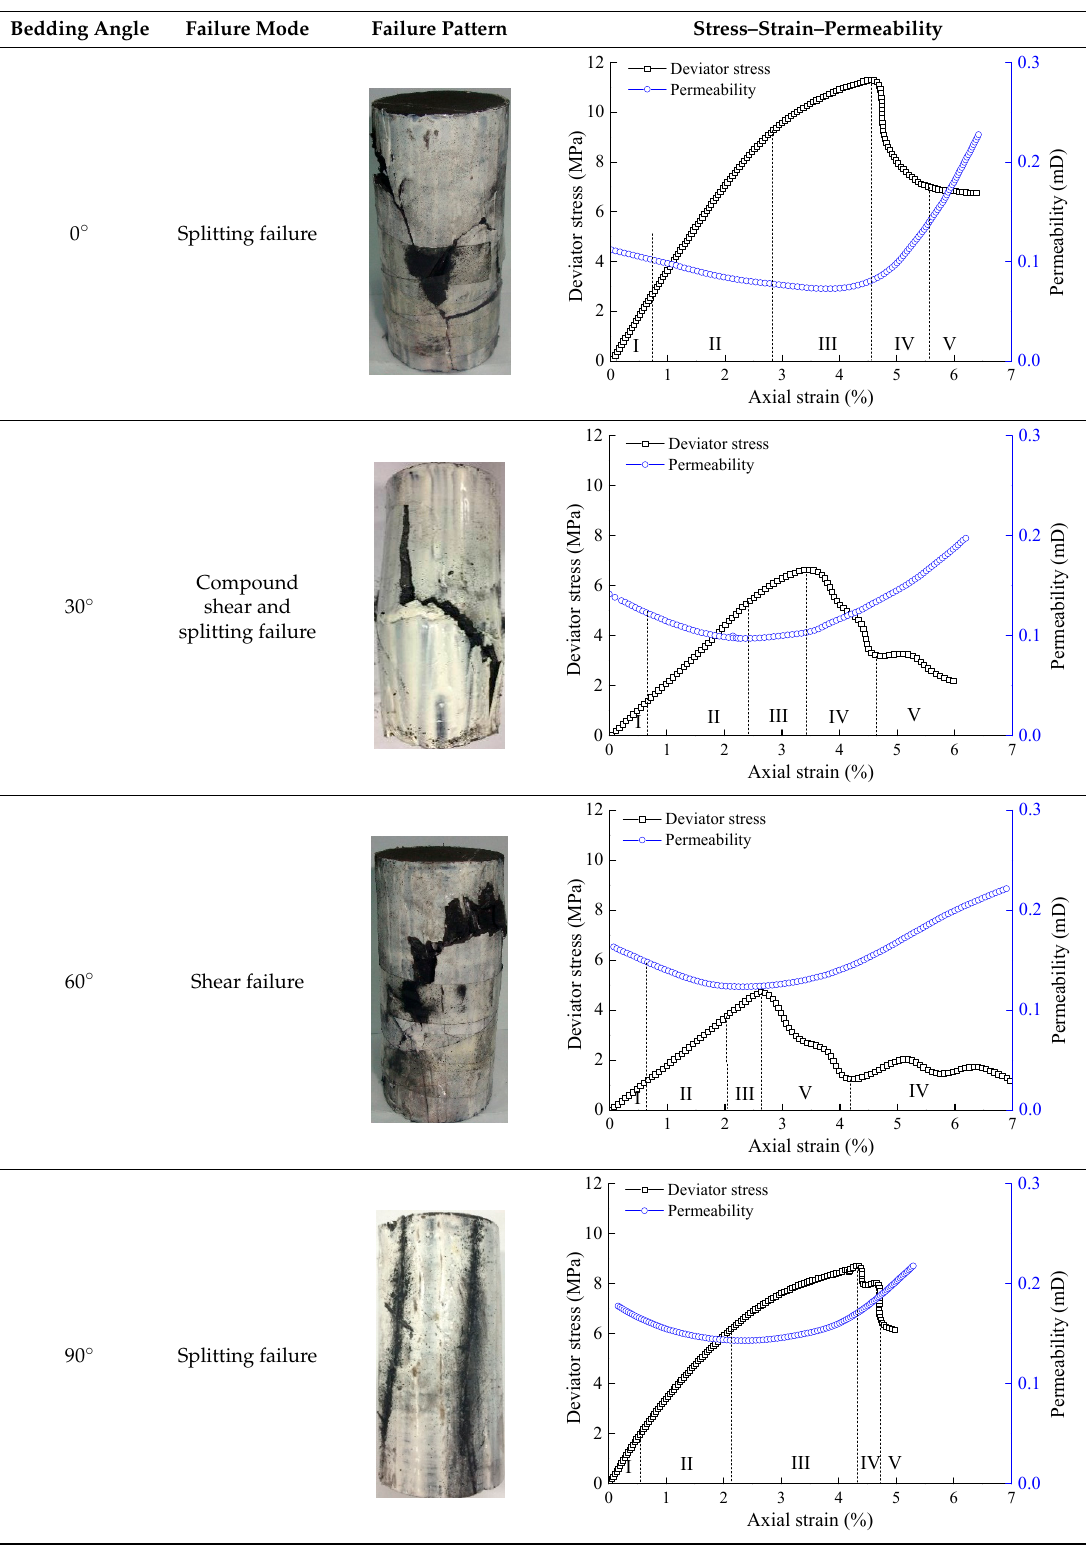
Table 3. Photos of post-compression specimens and stress–strain–permeability curves. Bedding Angle Failure Mode Failure Pattern